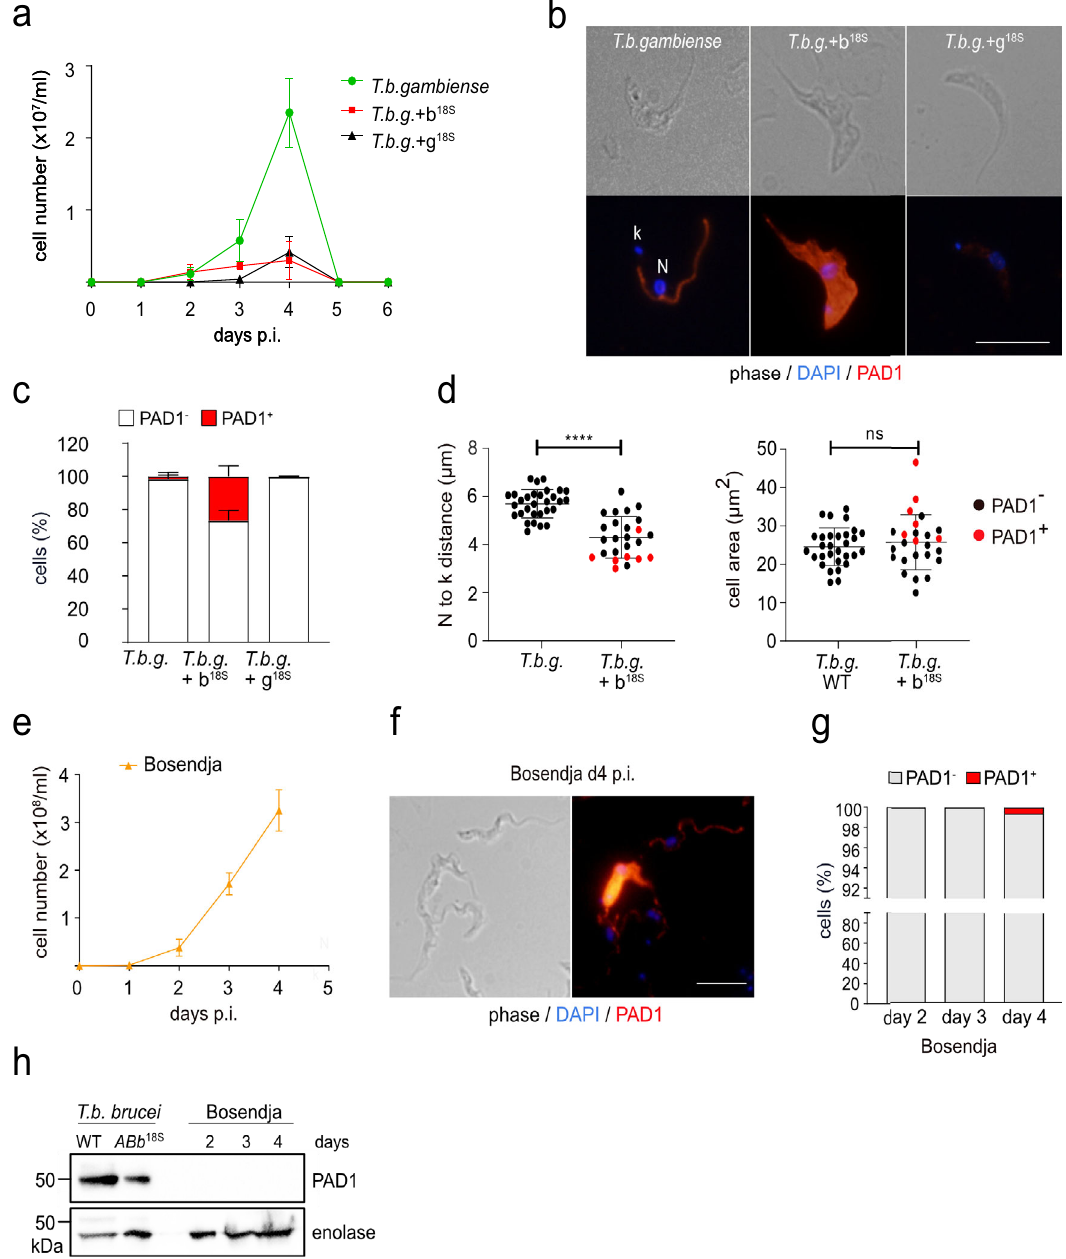
Fig. 5 | Restoration ofstumpy formation in T. b.gambiense . a Invivo infectivity of T. b. gambiense LiTat 1.3 ( T. b. gambiense ; green line) and T. b. gambiense expressing T. b. b . HpHbR ( T. b. g. + b 18S ; red line) and T.b. g . HpHbR ( T. b. g. + g 18S ; black line) from the 18S rRNA locus was evaluated by infecting mice with 3×10 6 cells ( n =3).The parasitemia wascounted daily tillday6 whenthe experiment was terminated. b Indirect immuno fl uorescence with PAD1 antibody (red), speci fi c for BS-ST in cell lines described in ( a ). DNA in the nucleus (N) and kinetoplast (k) was stained with DAPI (blue). Scale bar, 5 μ m. c Quanti fi cation of PAD1-positive and PAD1-negative cells (ex vivo), day 4 p.i.) in cell lines described in ( a ) ( n =3). In the columns, the stumpy formisshown in red. d Morphological characterization of T. b. gambiense and T. b. g. + b 18S cell lines containing the PAD1-negative cells (black dots)orPAD1-positivecells(reddots).Leftpanel:thedistancebetweenthenucleus